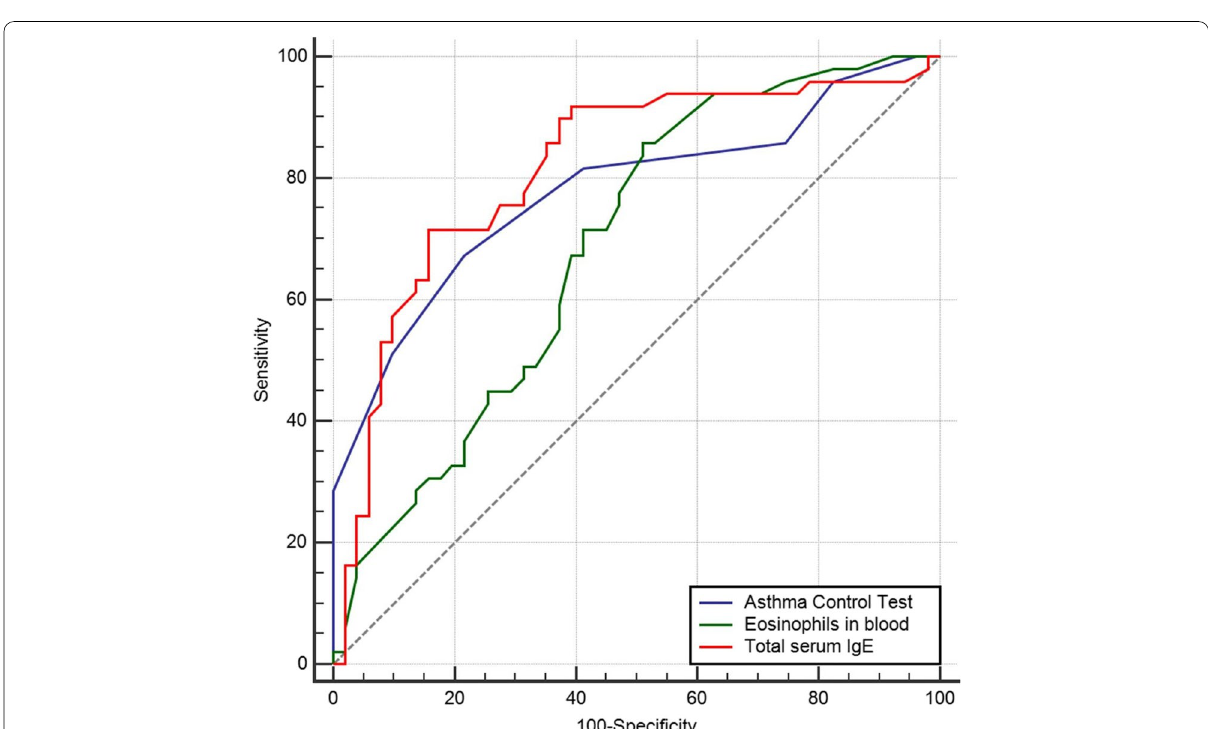
Fig. 1 Comparison of receiver-operating characteristic (ROC) curves for discrimination between patients with eosinophilic or non-eosinophilic asthma using the ACT score, blood eosinophil count or total serum IgE level